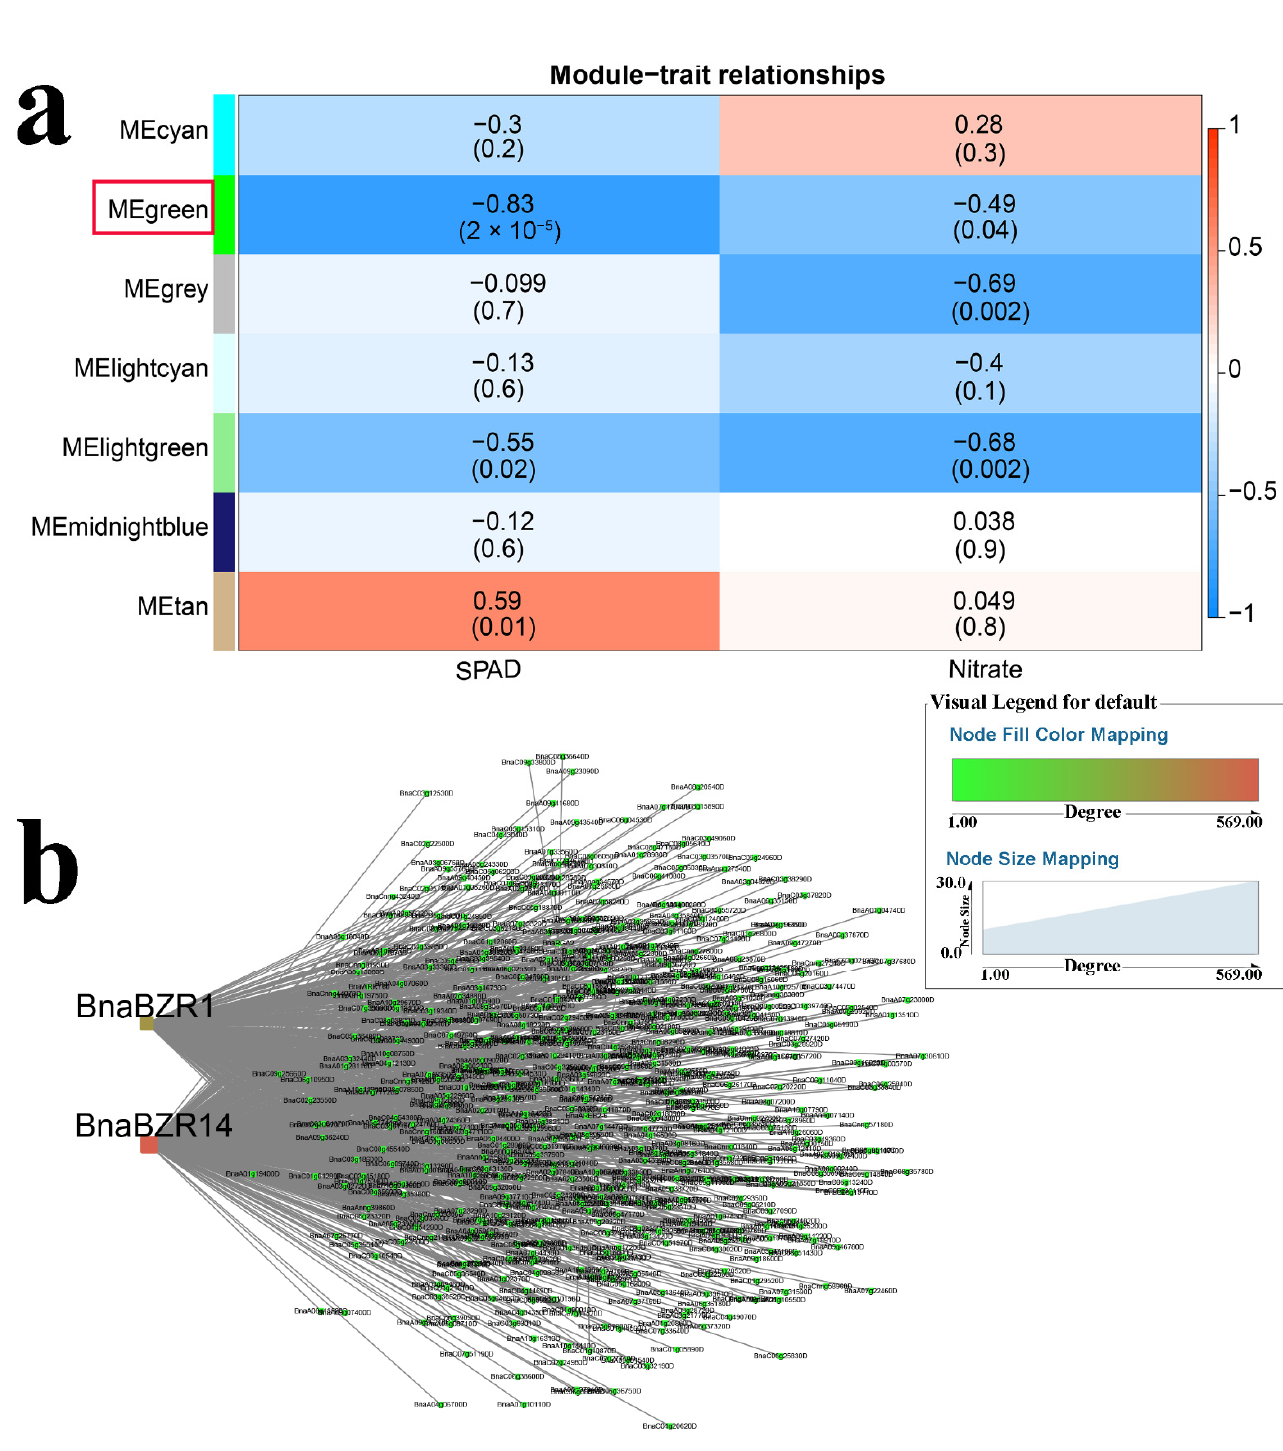
Figure 6. WGCNA of rapeseed genes in response to K starvation. ( a ) Module-trait correlation show- ing the significance of module eigengene correlation with traits (biomass and SPAD). Left panel shows modules. ( b ) Cytoscape representation of the relationship of hormone-related TFs in “light- cyan” module. Key genes are represented by large red circles. ( c ) Cytoscape representation of the relationship of hormone-related TFs in “turquoise” module. Key genes are represented by large red